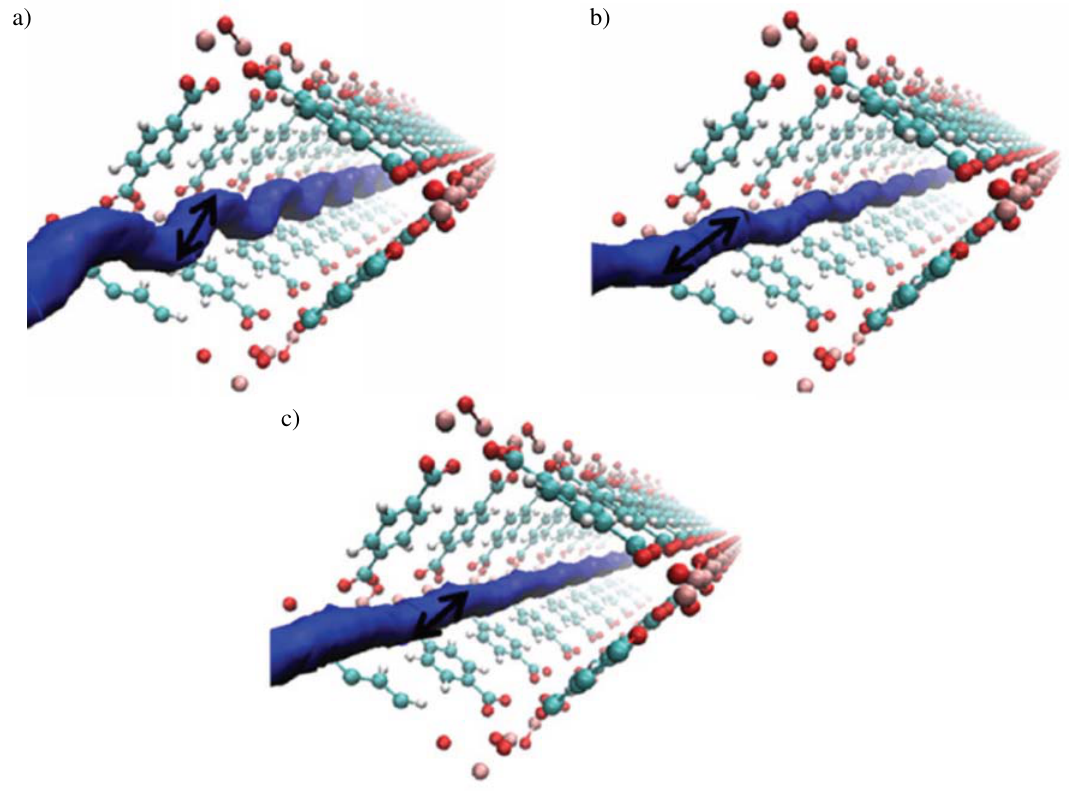
Figure 6 : Free-energy isosurface at 2 kJmol-1 deduced from the molecular dynamic calculations within the channels of Mil-47(V) for (a) C C - and (c) C -chain alkanes. 93 Reprinted with permission. Copyright 12 18